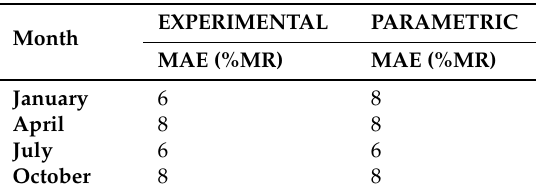
Table 6. Monthly mode values of MAE j , m for the months in Figure